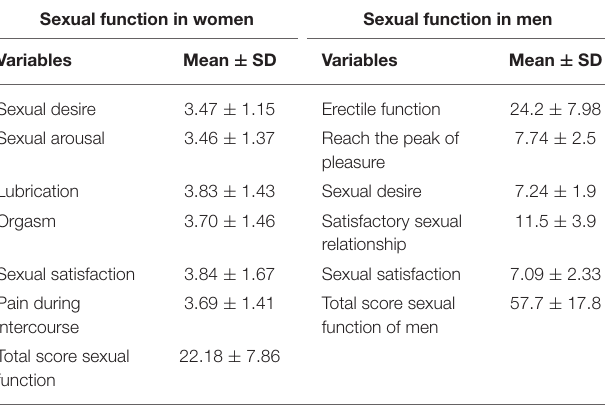
TABLE 2 | Sexual function in infertile women and men. Sexual function in women